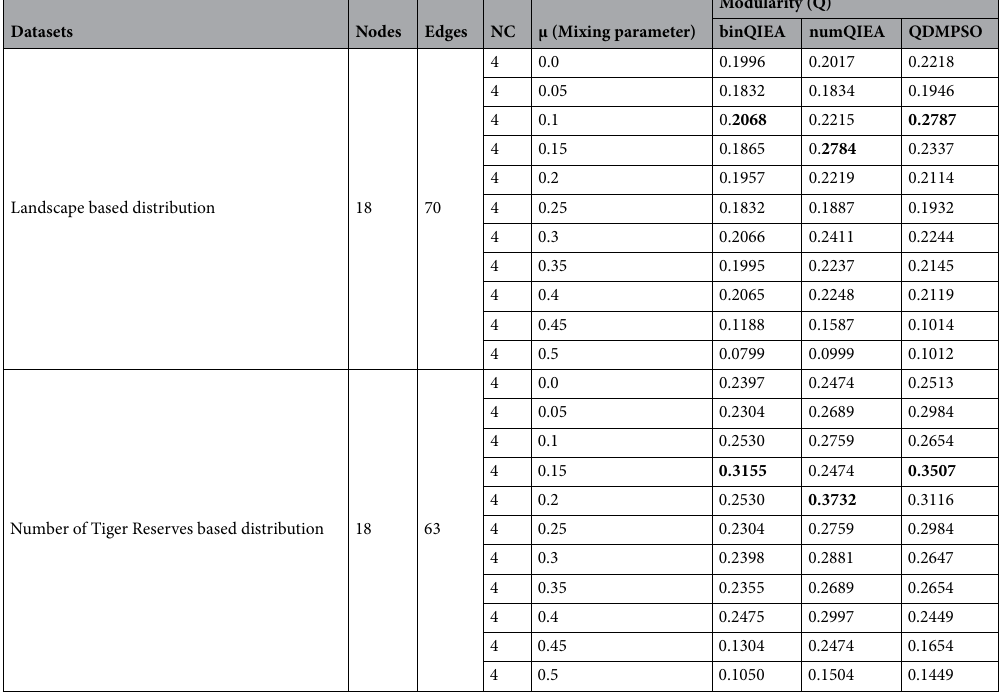
Table 2. Modularity based analysis of QIML based CD algorithms for varying values of mixing parameter— for Landscape based and Number of Tiger reserves based datasets.